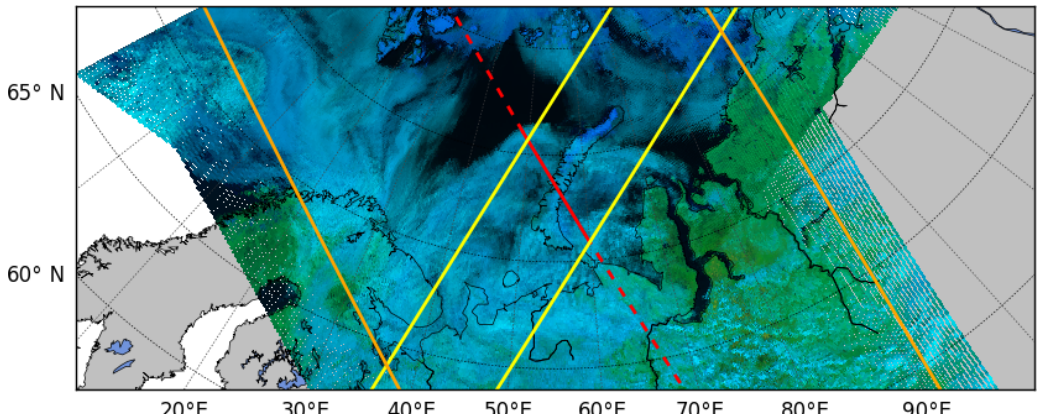
Figure 13. Study area SIB (Siberia). As Fig. 9, but on 27 July 2008, 08:10LST.